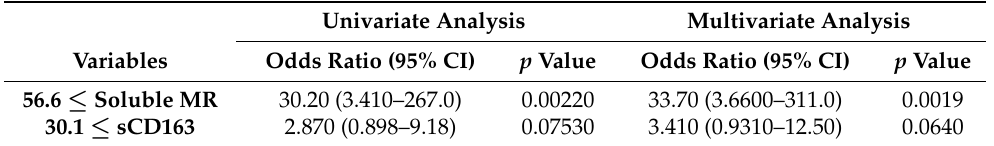
Table 3. Univariate and multivariate analyses of predictive markers for symptom development in patients with primary biliary